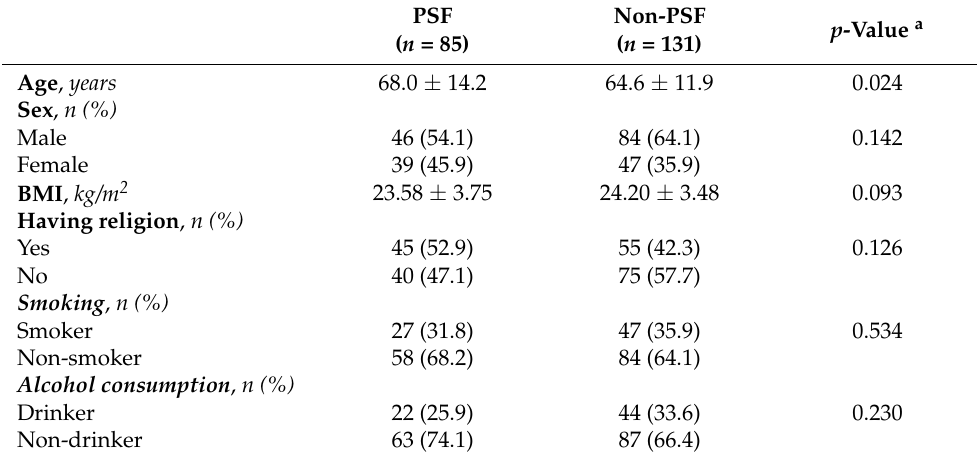
Table 1. Comparison of demographic characteristics between the PSF and non-PSF groups.